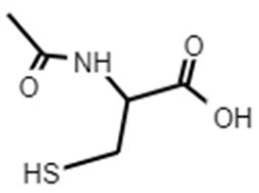
Figure 3. Chemical structure of NAC. Table 6. Recent reported studies on antibiofilm activities of NAC.